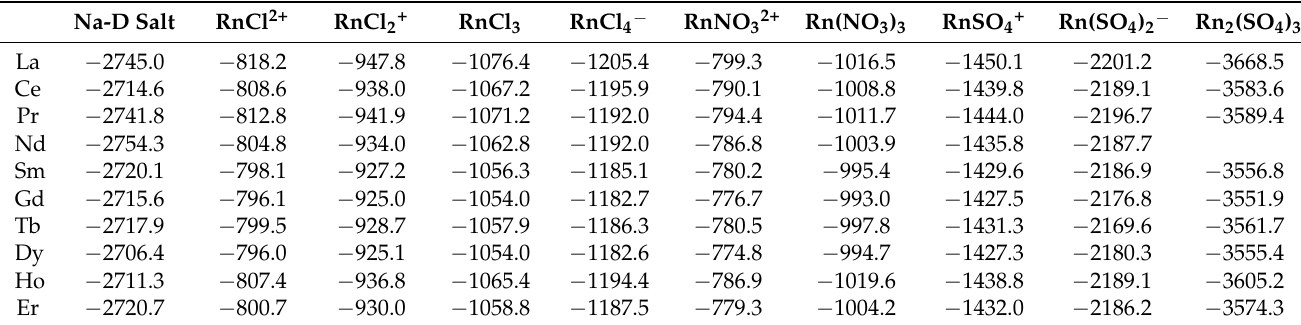
Table 1. The Gibbs standard free energy formation of various compounds in kJ/mol. (Information taken from references [22,25,26] with some